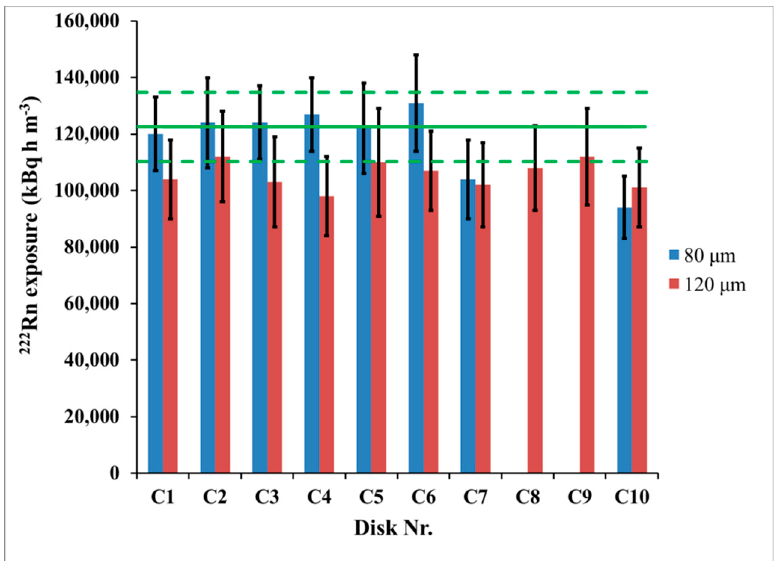
Figure 6. Variation of individual results between disks from one set at depths 80 µm and 120 µm. Disks C8 and C9 were analyzed only at 120 µm. The error bars correspond to the “one sigma” combined uncertainty (counting uncertainty and calibration uncertainty). The horizontal line represents the reference 222 Rn exposure and the dashed lines show its 95% confidence interval (“two-sigma” interval).